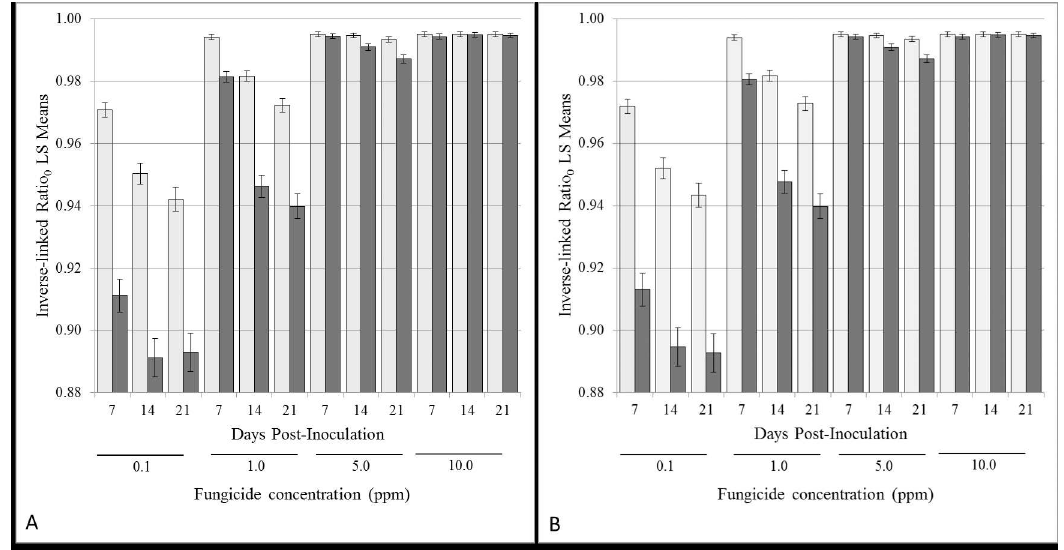
Fig 2. Comparison of LS-Means for the three-way interaction, Media * Day * Method, where dark bars represent measuredArea(M A ) and light bars represent area calculated from Diameter(D A ). A. Inhibitionratios calculatedusing un-amended PDA as control (Ratio 0 ) for each time point, Days 7, 14 and 21 for each fungicidelevel tested. B. Inhibition ratios calculatedusing acetoneamendedPDA as control (Ratio A ) for each time point, Days 7, 14 and 21 for each fungicide level tested. The error-bars are the 95% confidenceintervals for each mean.